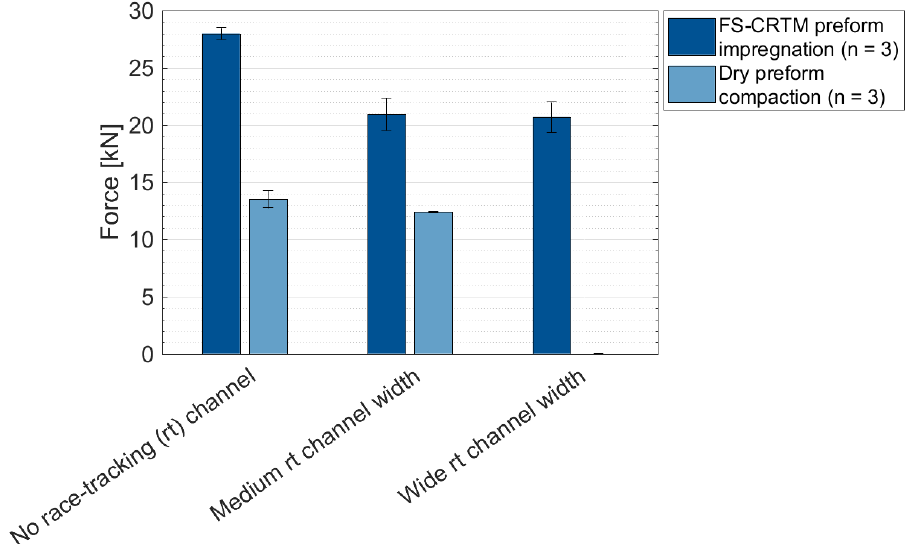
Figure 9. Maximum recorded force of the three experimental scenarios of the race-tracking study. Bar heights give the mean value, and the error bars indicate the standard deviation of three repetitions.